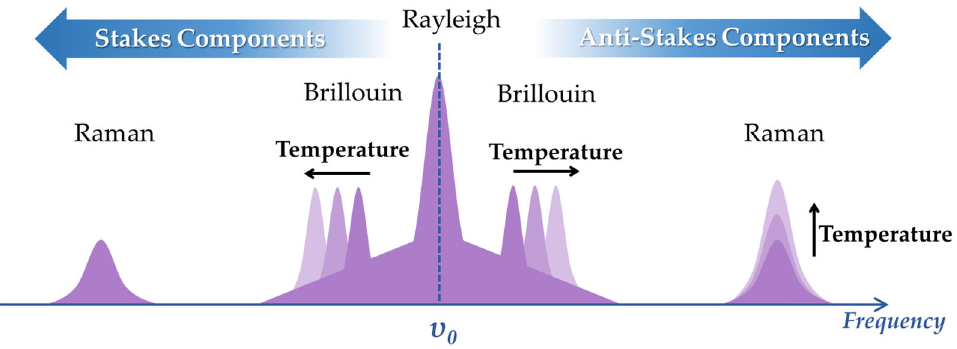
Figure 10. Light emission from Rayleigh, Raman, and Brillouin